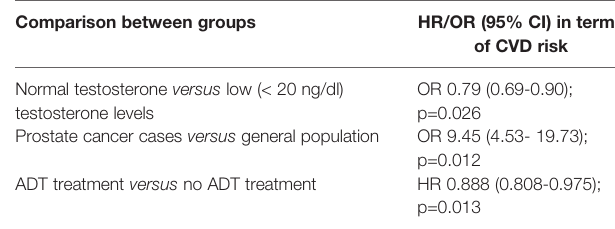
TABLE 1 | Comparison between groups in terms of CVD risk. Comparison between groups HR/OR (95% CI) in terms